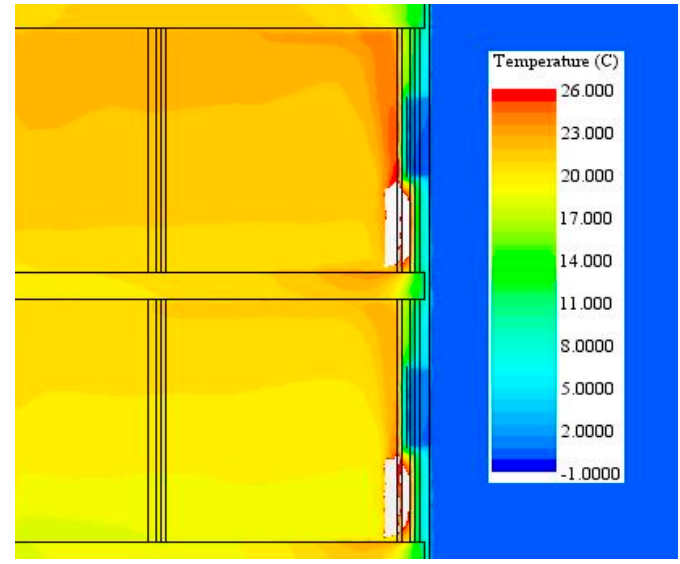
Figure 10. Building vertical section detail.